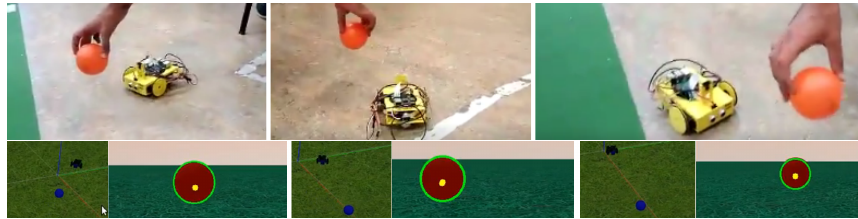
Figure 16. Navigation exercise of following a colored object using vision in both real and simulated PiBot platforms.